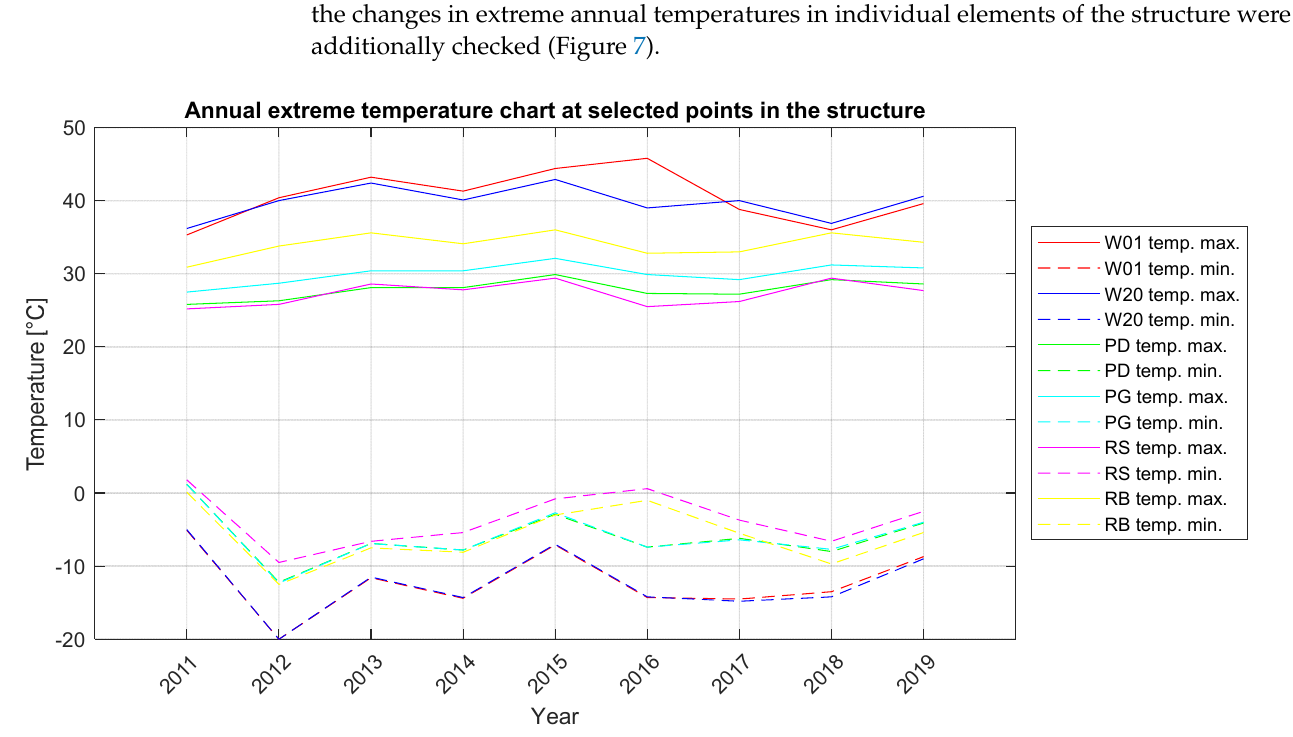
Figure 7. Annual extreme temperature chart at selected points in the structure.